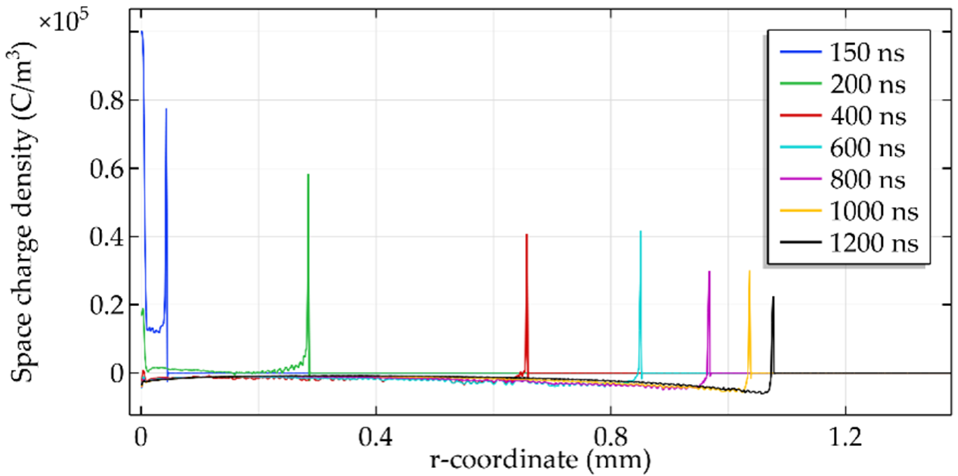
Figure 10. Electric field magnitude (kV/mm) along the line ( I ) at several instants in the 1st case.